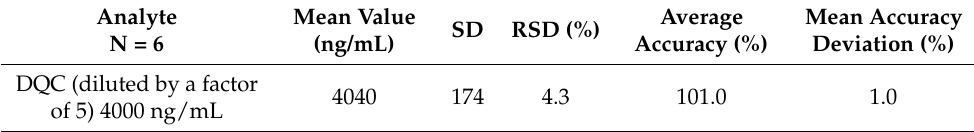
Table 4. Evaluation results of dilution reliability of plasma samples diluted up to five